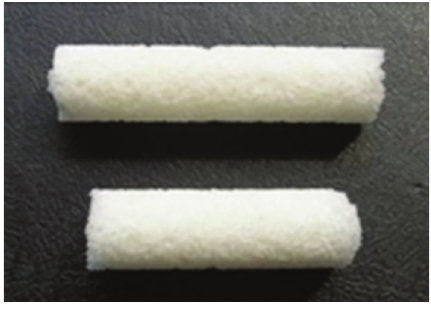
Figure 2: Columnar n-HA/PA blocks.